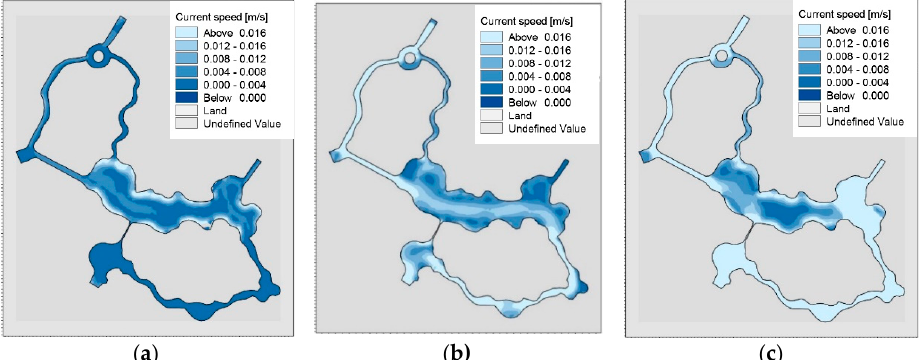
Figure 8. ( a ) Flow field without water diversion; ( b ) Flow field after pump diversion 30 h; ( c ) Flow